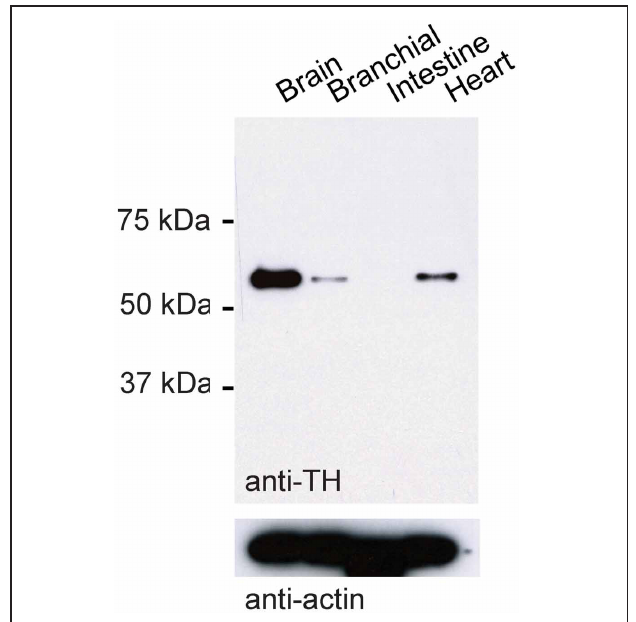
FIGURE 1 | Western blot control for TH antibody. Western blot using TH antibody and protein extracts from different tissues of adult zebrafish. Bottom: loading control using antibody against